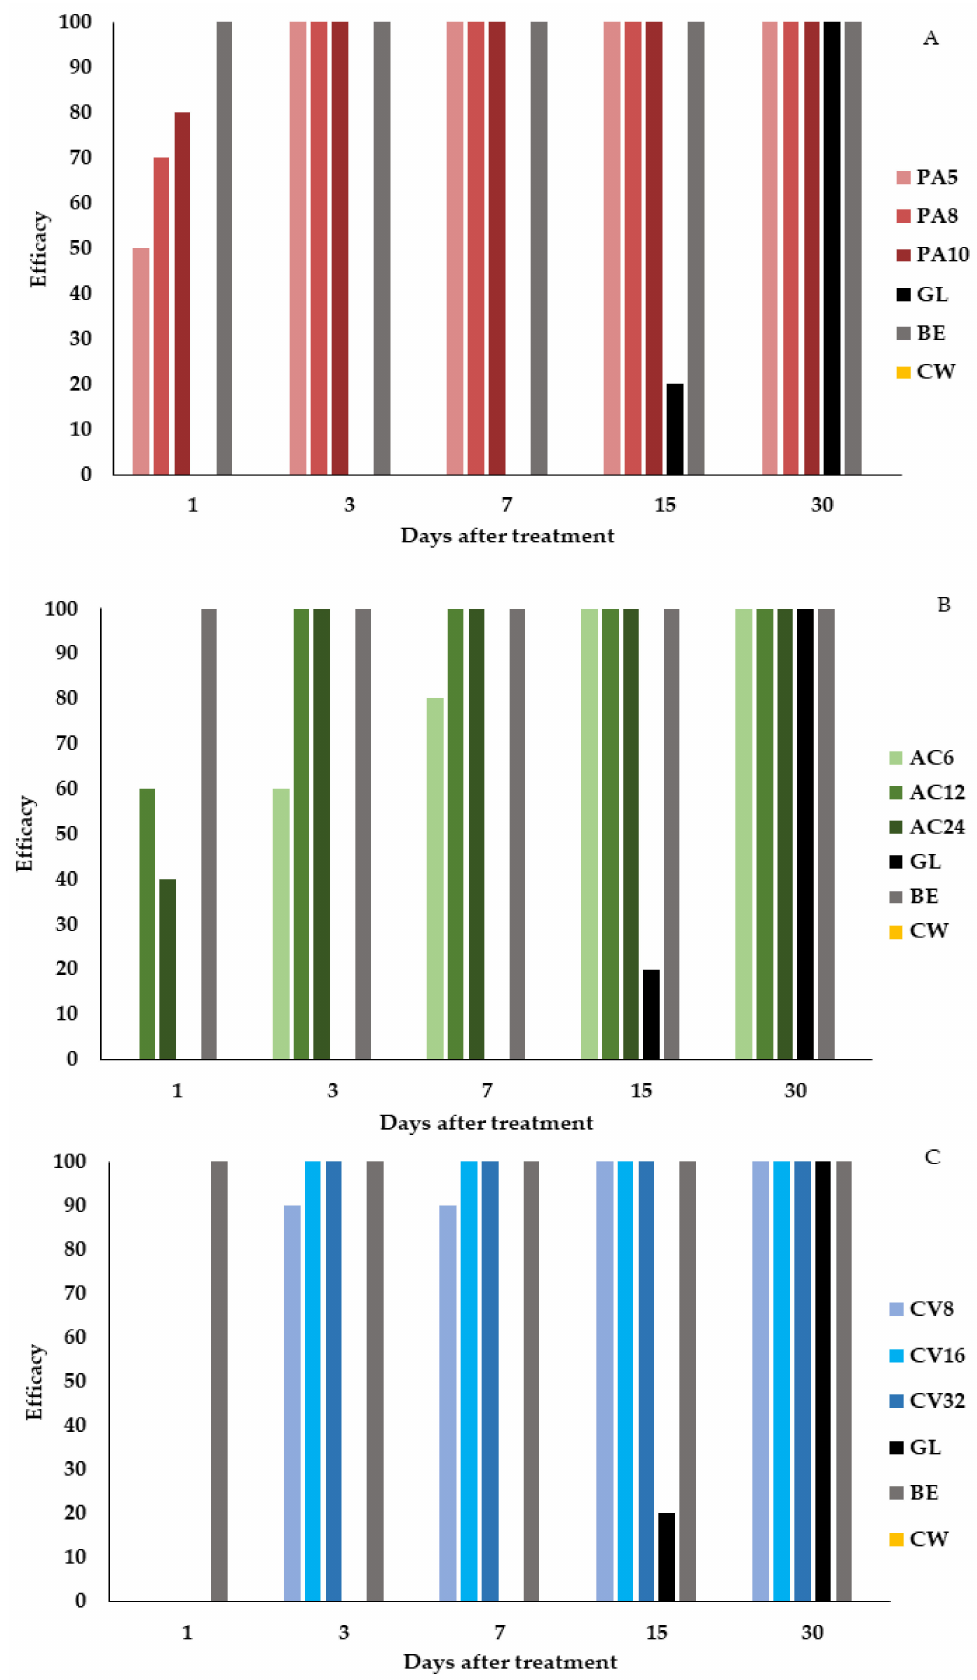
Figure 6. Evolution of e ffi cacy of the tested treatments ( A ) pelargonic acid, ( B ) cinnamic aldehyde, and ( C ) carvacrol in E. bonariensis during 30 days after their